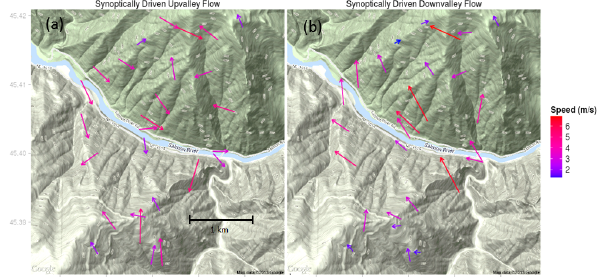
Figure 16. Characteristic (a) synoptically driven upvalley flow (15:00 LT) and (b) downvalley flow (11:00 LT) at the Salmon River Canyon site during July–September 2011. Vectors represent the av- erage hourly flow at a given sensor. Periods of weak synoptic forc- ing were removed prior to averaging.